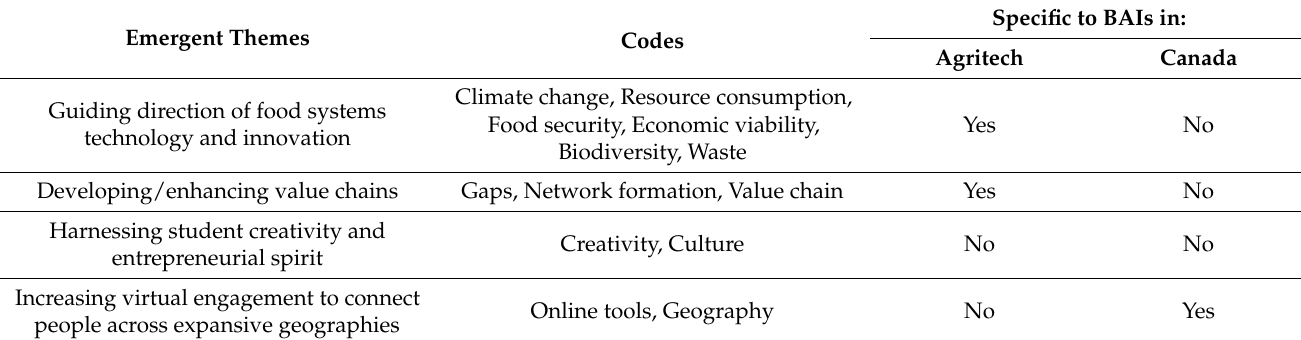
Table 2. Opportunities related to increasing agritech incubator and accelerator